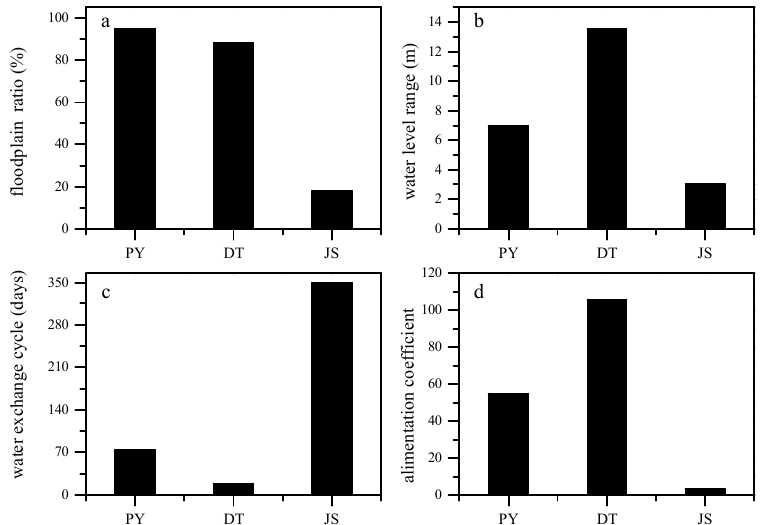
Figure 3. Floodplain ratios ( a ), water level ranges ( b ), water exchange cycles ( c ), and alimentation coefficients ( d ) of lake Poyang (PY), Dongting (DT), and Junshan (JS). The bimultivariate redundancy statistic showed that the local process explained 26.3% (adjusted R 2 = 0.196) and 49% (adjusted R 2 = 0.282) of inter-lake zooplankton variances in the high and low water level seasons, respectively.